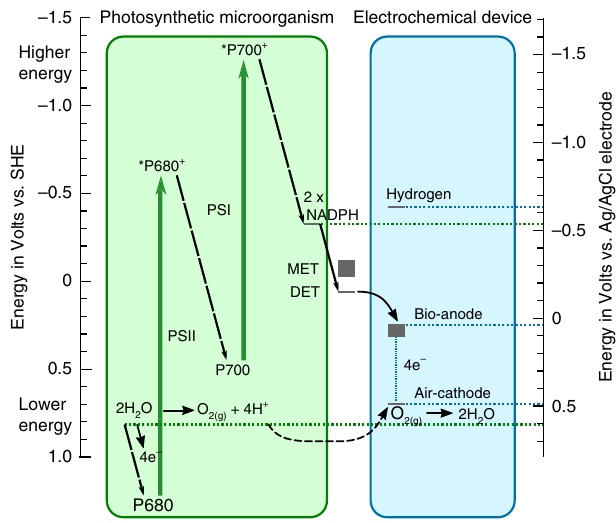
Fig. 1 BPV energetic scheme. Energy levels (at physiological pH) inside photosynthetic organisms and charge transfer to external electrodes of biophotovoltaic